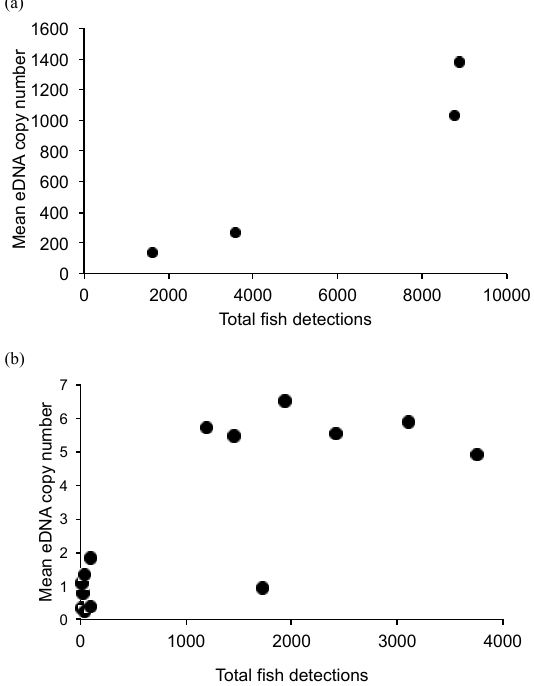
Figure 2. Relationship between mean eDNA copy number and the number of fish detections at the test side during each period and day for each attractant type: ( a ) spirulina food for silver carp, ( b ) PGF2 α pheromonal sex stimuli for male common carp.